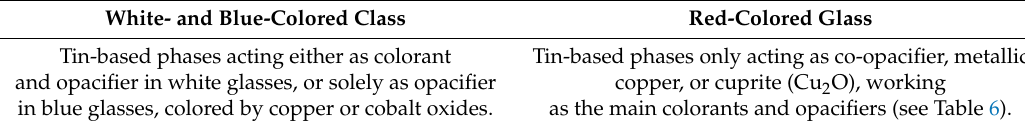
Table 4. Tin-based